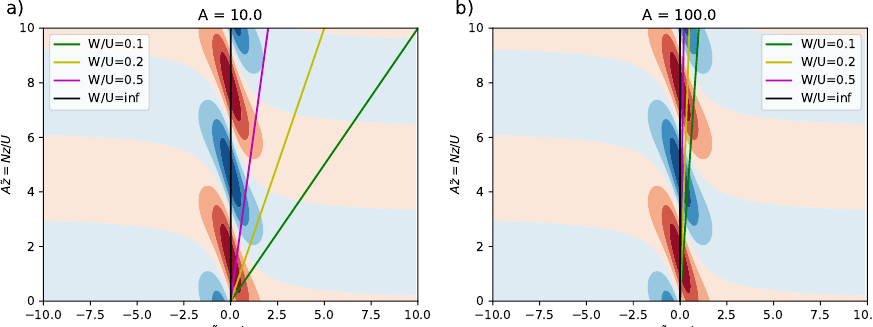
Figure 2. Vertical velocity from the Queney mountain wave solution for ( a ) A = 10 and ( b ) A = 100. Plotted on top are the virtual radiosonde trajectories for non-dimensional ascent rates, W / U = 0.1,0.2,0.5, and ∞ (a vertical